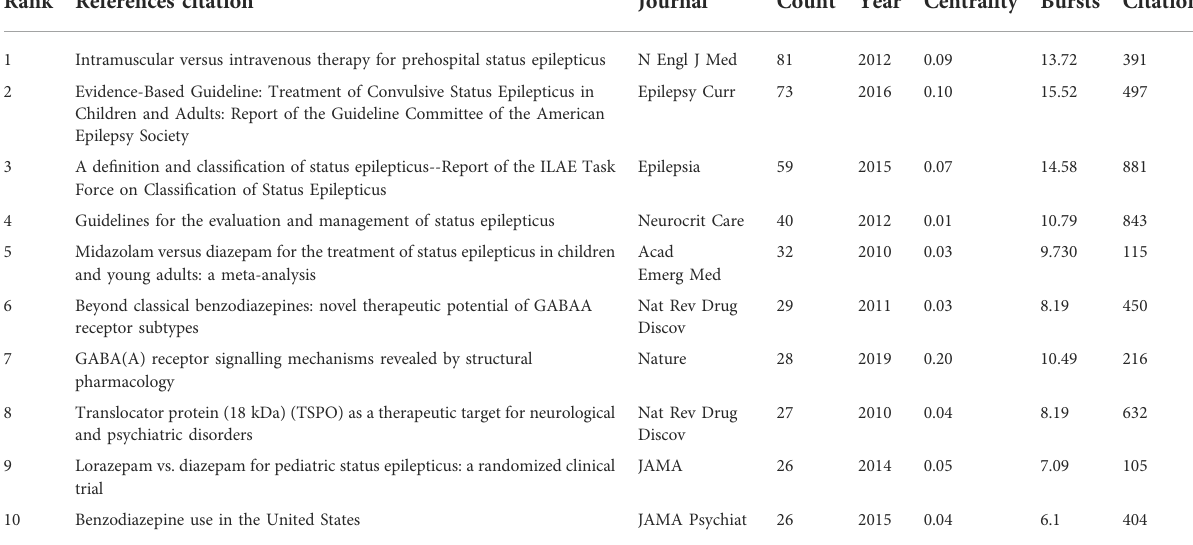
TABLE 4 Top 10 co-cited references and references with citation bursts related to diazepam.